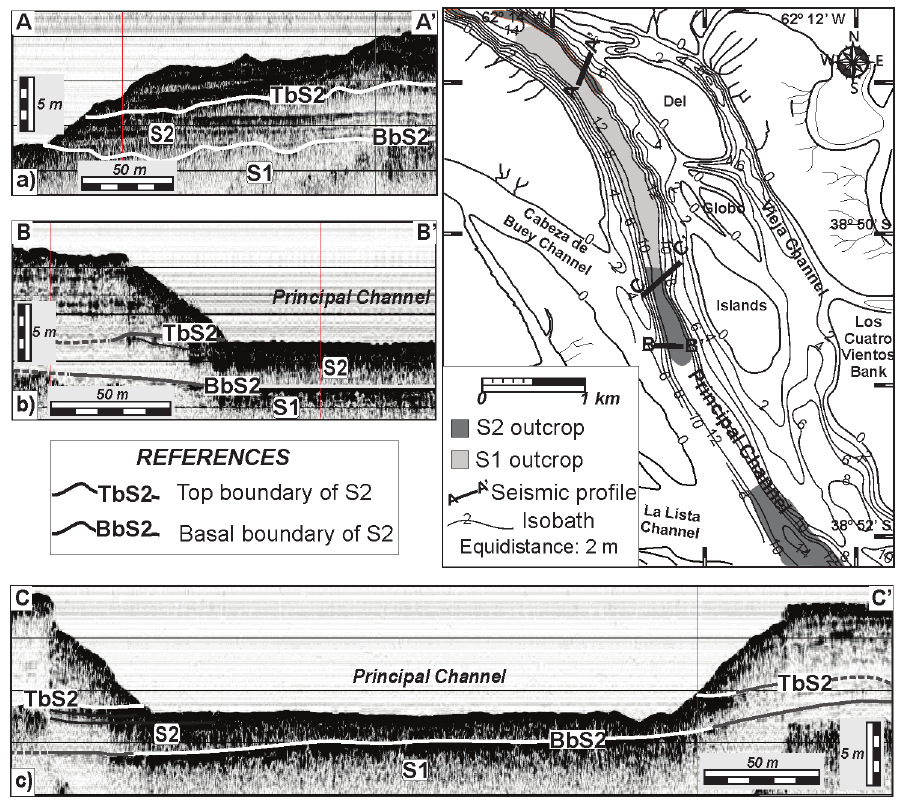
Fig. 2 - Seismic sequences S1 and S2. Areal distribution and seismic